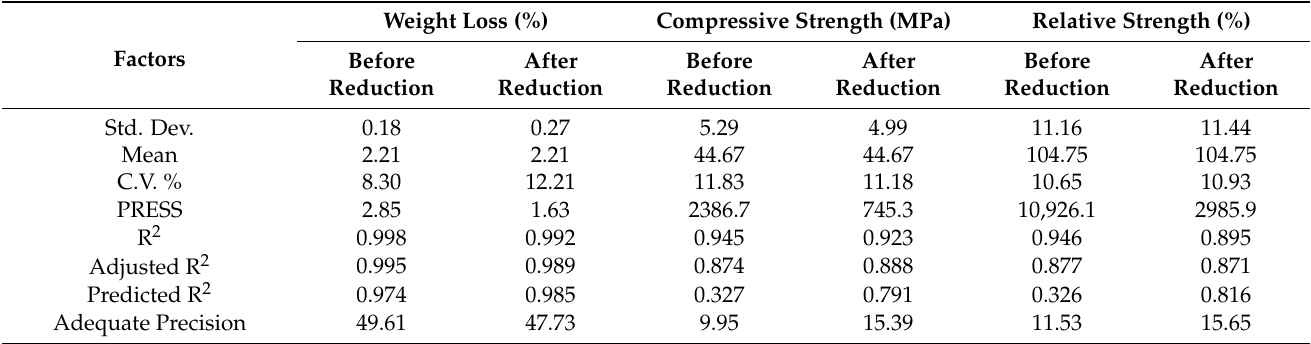
Table 8. ANOVA models